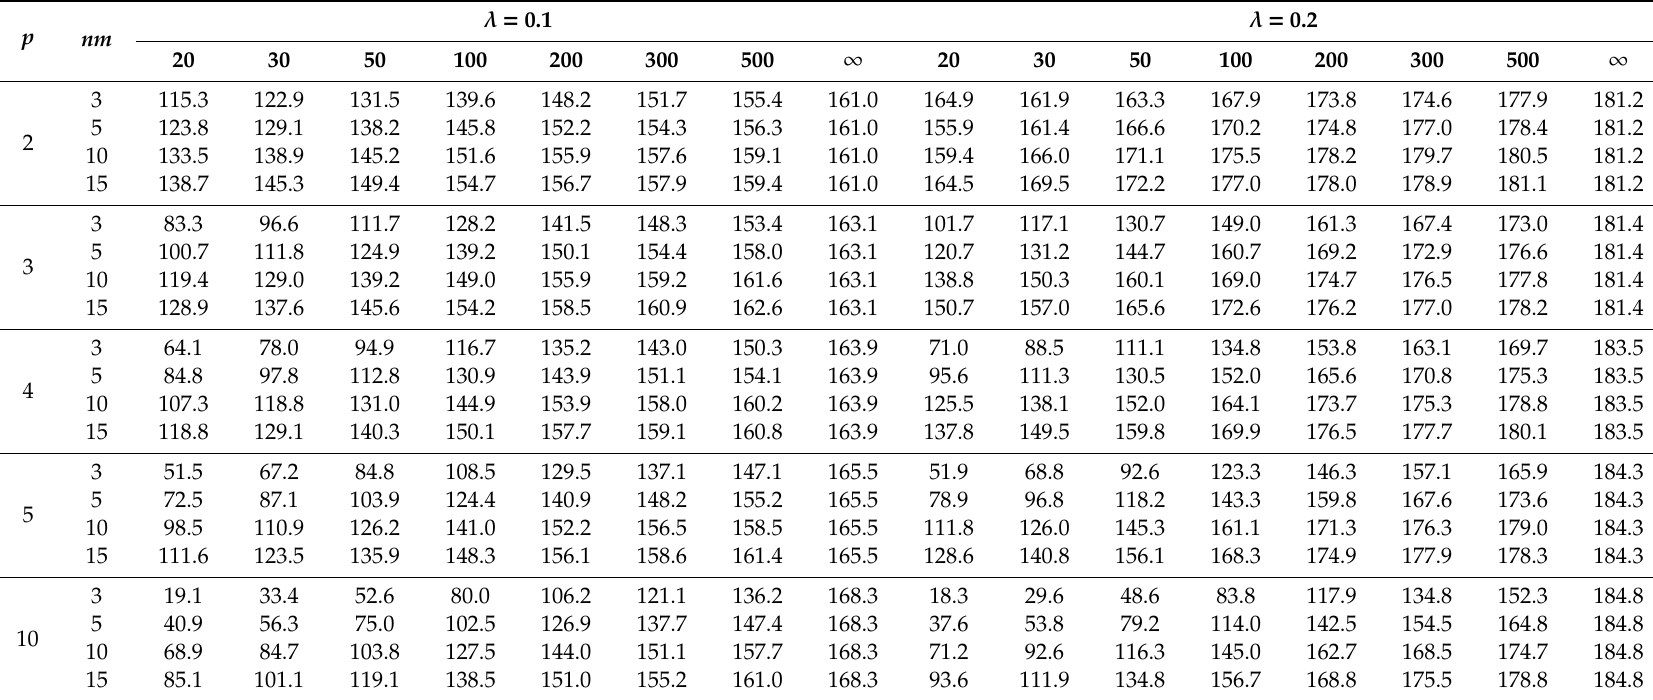
Table 7. Corrected control limits coe ffi cients